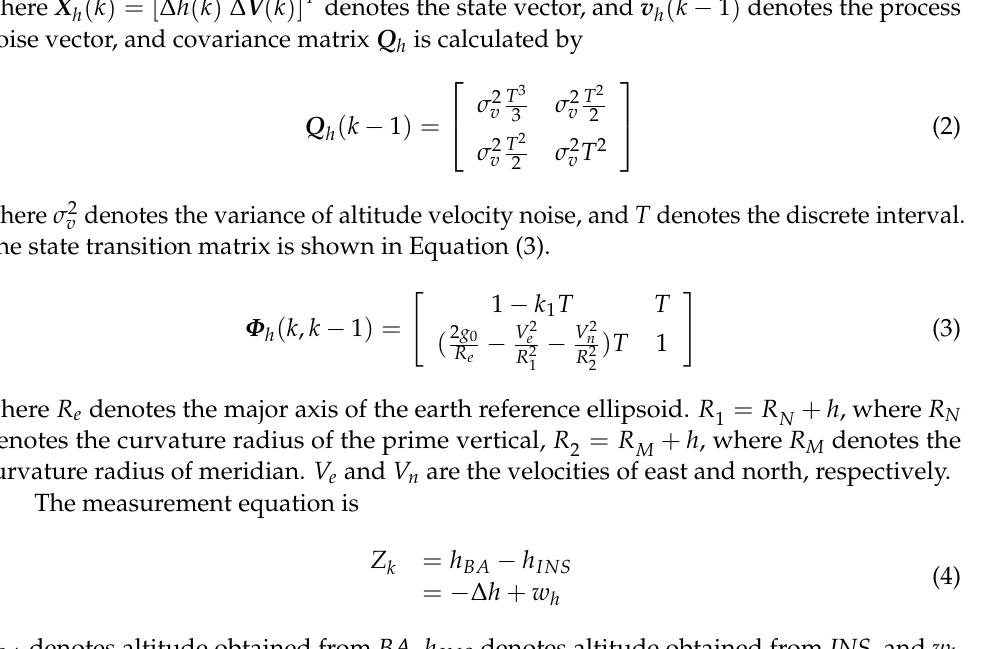
Figure 4. INS/JTIDS/BA integration